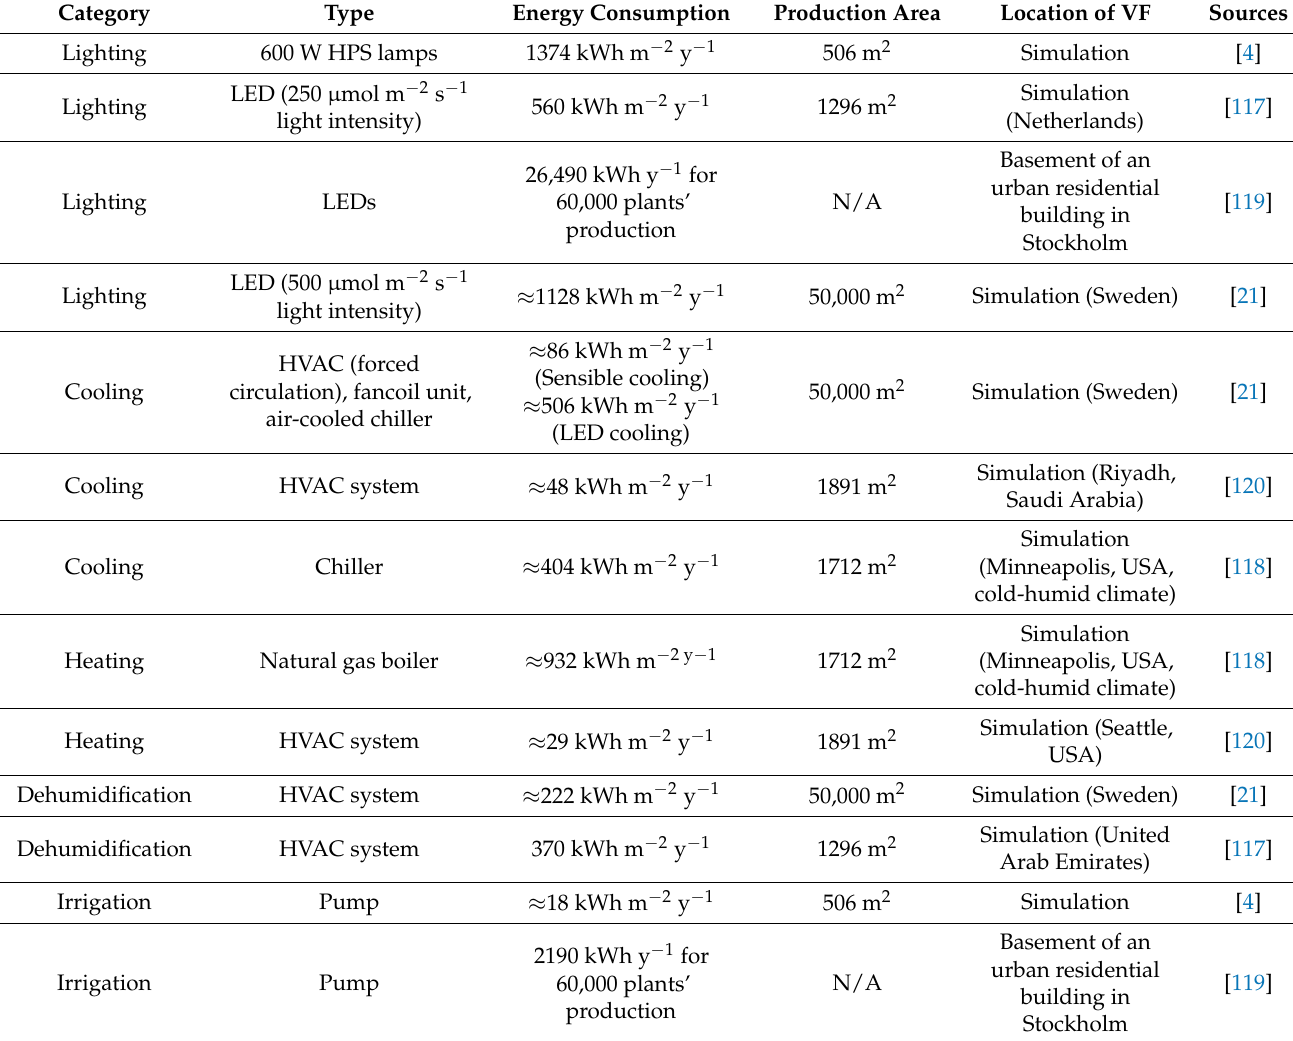
Table 2. Energy demand for operation systems of a